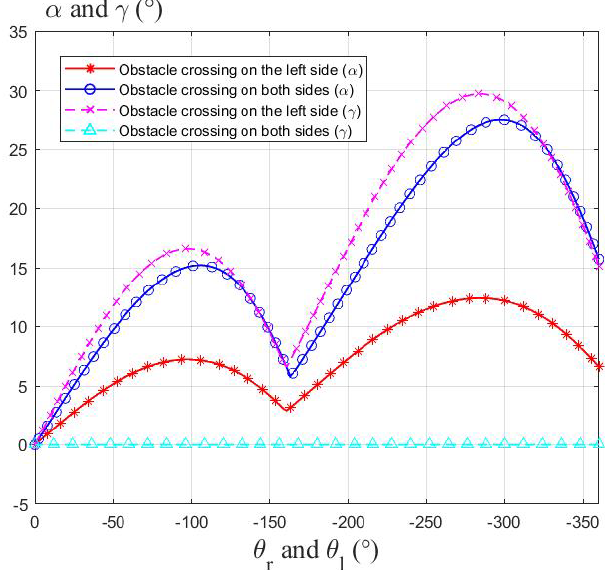
Figure 12. The curves of the pitch angle α and the roll angle γ changing with the swing angle of the adaptive climbing rocker arm.